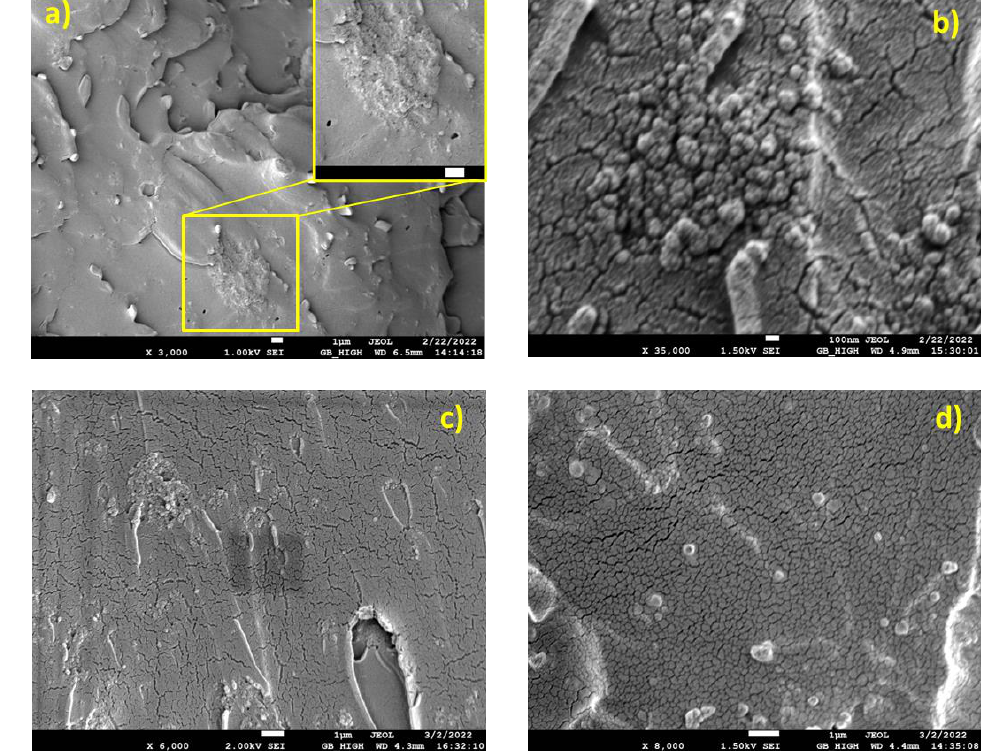
Figure 3. SEM micrographs of Resin/SiO 2 micro-composites, ( a ) Resin/0.5, ( b ) Resin/1.0, ( c ) Resin/1.5.